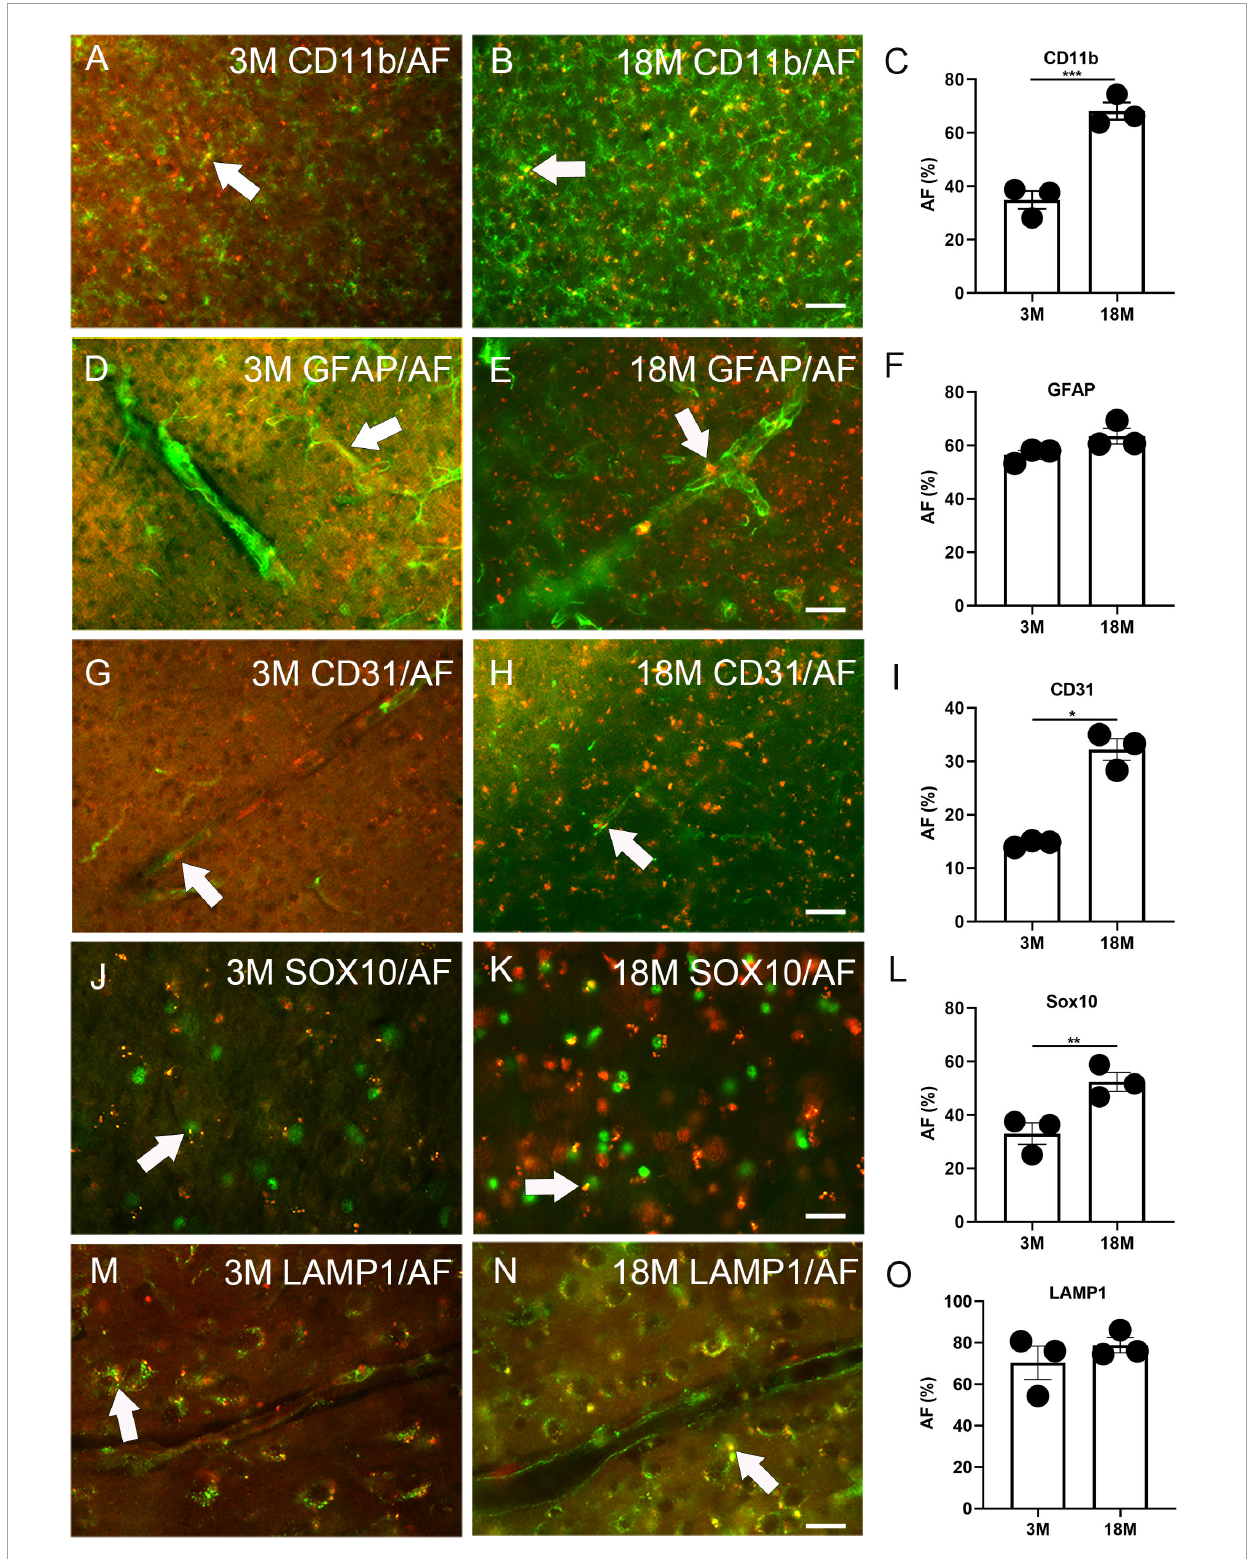
FIGURE2 Autofluorescence (AF) expression in glial cells, blood vessels, and lysosomes of young and aged mice. The representative AF images (rhodamine channel) co-localized with CD11b (A–C) , GFAP (D–F) , CD31 (G–I) , Sox10 (J–L) , and LAMP1 (M–O) among young (3M) and aged brains (18M). The arrows depict fluorescence coincident with AF. The scale bars represent 40 µ m (A,B,D,E,G,H) and 20 µ m (J,K,M,N) . The data are represented as mean ± SE. Significance analysis with t -test. * p < 0.05, ** p < 0.01, *** p <